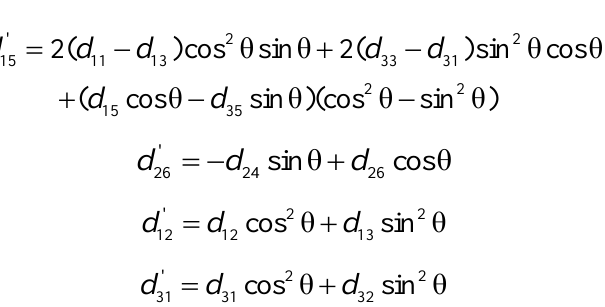
, d , d and d (the same as d 11 12 31 15